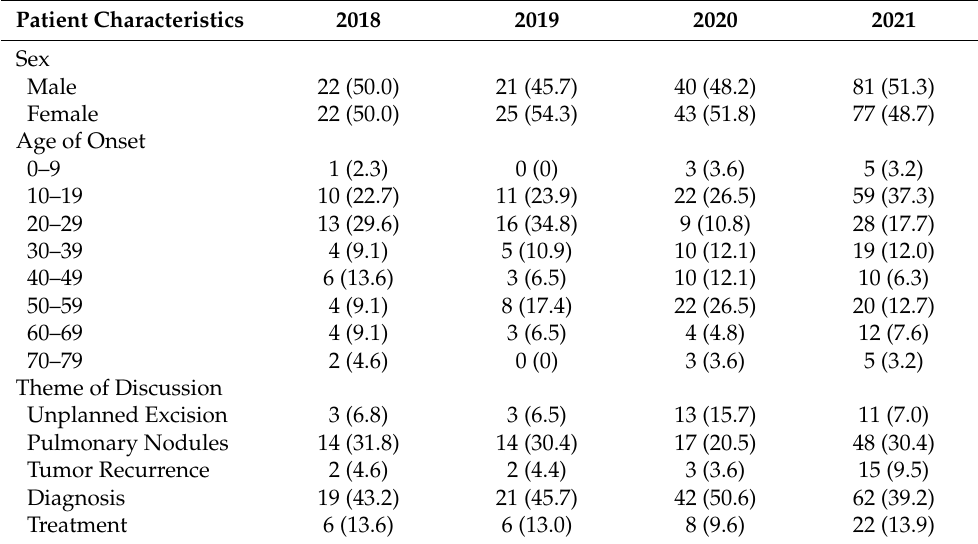
Table 1. Demographic data of patients discussed by the MDT during each year of the